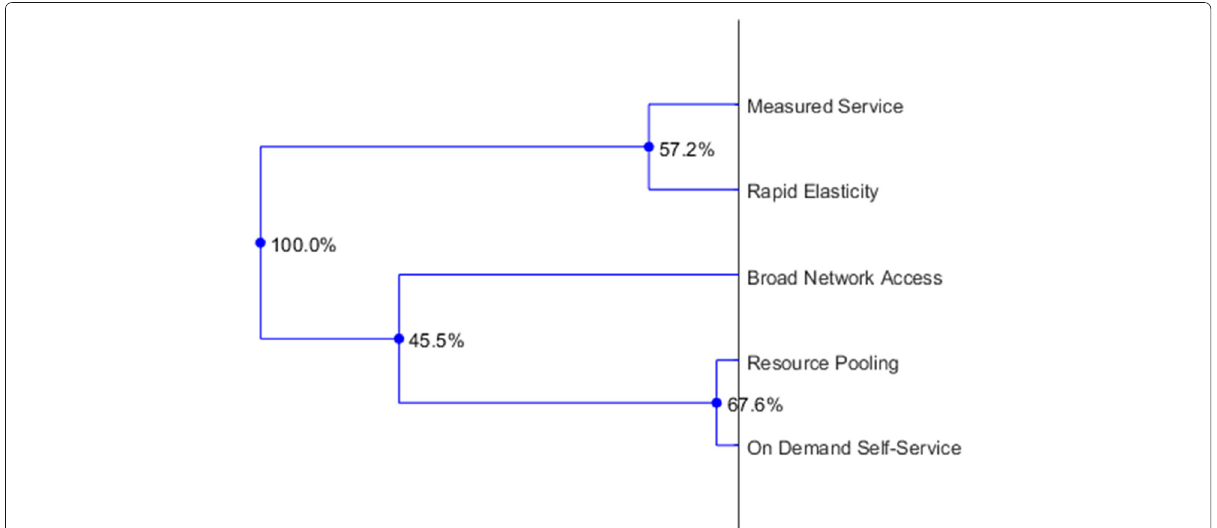
Fig. 6 Hierarchical dendrogram of variables in a 2-dimensional representation of the decomposition of the 5-dimensional partitioned dataset for the essential characteristics. Internal nodes are labelled with bootstrap percentages indicating the proportion of times in 1000 bootstrap replicates of the CA analysis that a node is observed. The two distal nodes with values >50% indicate that no other arrangement occurred more often in the bootstrap replicates, and that they are therefore strongly supported. The association of BroadNetworkAccess with either distal node is then the only remaining degree of freedom, and occurs roughly half of the time with each (45.5% vs. 54.5%). Looking again at the biplot in Fig. 4 we see that this would result from only slight alterations to the angle of the vector towards either OnDemandSelf-Service , or towards MeasuredService . Overall, this